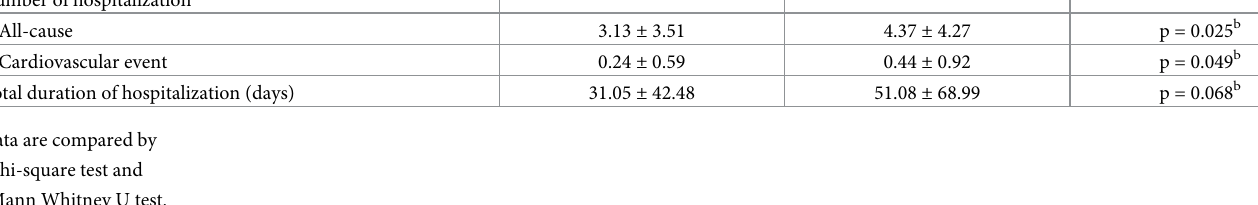
last correlation did not reach statistical significance. In contrast, WHR did not correlate with tion of hospitalization (p = 0.4). By using linear regression model after log transformation to adjust for potential confounders, frailty score remained an independent factor associated with the number of hospital admission for all-cause and total duration of hospitalization (Table 5). We further performed subgroup analysis on hospitalization data according to physical frailty. In short, general obese patients were hospitalized more frequently with a longer hospi- talization period, while central obese patients were hospitalized less frequently with a shorter period (Table 6). In non-frail patients, those with general obesity had more than a doubled number and duration of cardiovascular-event related hospitalization as compared to those without general obesity, while those with central obesity had halved number and duration of similar trend was also observed in frail patients, but the difference was not significant (S2 Table).